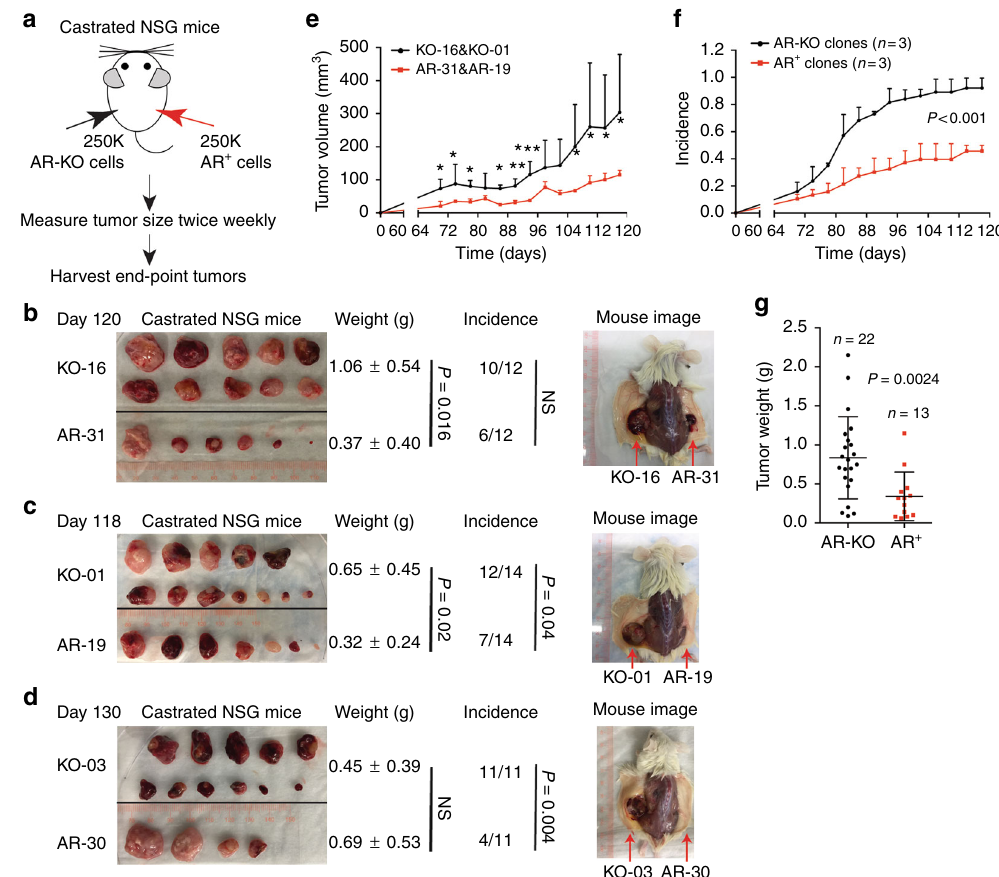
Fig. 4 AR-KO PCa cells are highly tumorigenic in castrated mice. a Experimental design. Three ‘ pairs ’ of LNCaP clonal cells were used in tumor regeneration experiments: KO-16 and AR-31 ( n = 12 mice; b ); KO-01 and AR-19 ( n = 14 mice; c ); and KO-03 and AR-30 ( n = 11 mice; d ). b – d Images of endpoint tumors and tumor-bearing mice, and tumor weight and incidence with corresponding P -values. P -values for tumor weight and incidence comparisons were determined using unpaired Student ’ s t -test and χ 2 test, respectively. NS not signi fi cant. e Higher growth rate of AR-KO tumors in castrated mice. Tumor volumes were measured twice weekly in castrated NSG mice bearing AR-KO (KO-16 and KO-01) and AR + (AR-31 and AR-19) injections, starting from day 64 post implantation (mean± SD). * P < 0.05; ** P < 0.01; *** P < 0.001 Student ’ s t -test). f Tumor incidence in all 3 groups of animals starting from day 64 post implantation (mean± SD). P < 0.01 for all time-point comparisons (Student ’ s t -test). g Graphical presentation of endpoint tumor weights in b and c .